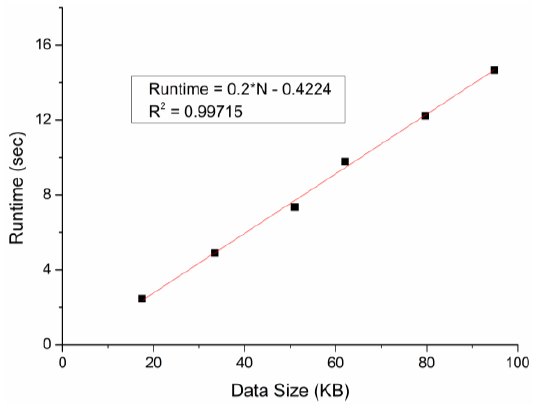
Figure 9. The quantitative relationship between input points size and IDW interpolation time.